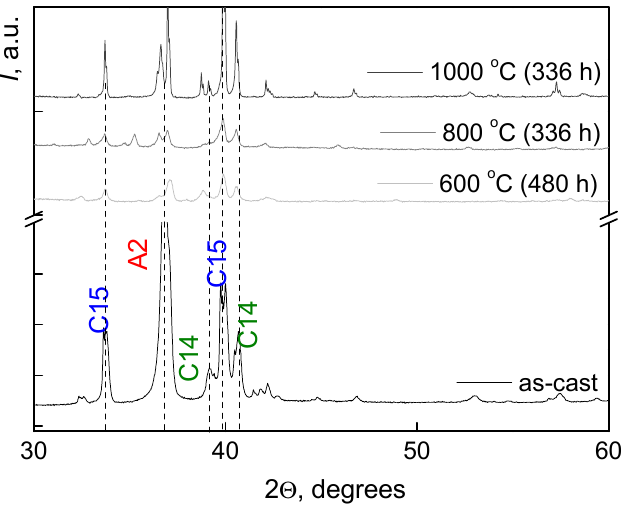
Figure 6. Diffraction patterns for the TiZrHfMoCrCo alloy in the as-cast state (black line) and annealed state (light gray: 600 ◦ C for 480 h; gray: 800 ◦ C for 336 h; and dark gray: 1000 ◦ C for 336 h). Table 3. Phases, lattice parameters a , c , and the percentage of the phases V in the TiZrHfMoCrCo alloy after anneals at 1000 ◦ C, 800 ◦ C, and 600 ◦ C. The anneals at 800 and 600 °C (Figure 5) showed that the (A2) phase is stable in the temperature range of 600–1000 °C (Table 3), its percentage is low (around 4 %) and lat- tice parameter remains almost constant.